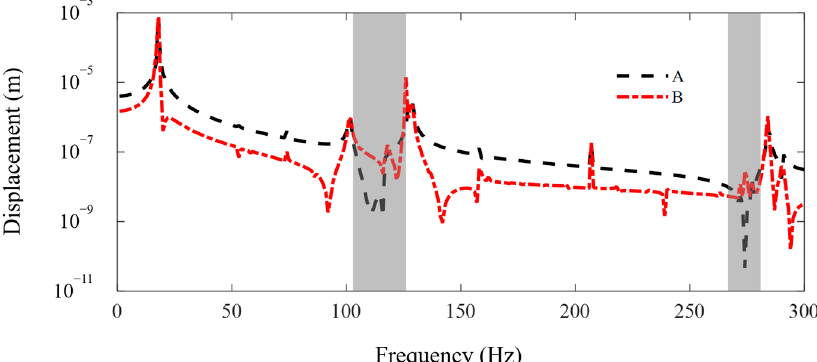
Figure 6. The FRF curves of the metamaterial plate at points A and B of the cover plate along the x axis. The dotted line and the dash-dotted line denote the FRF curves of points A and B.